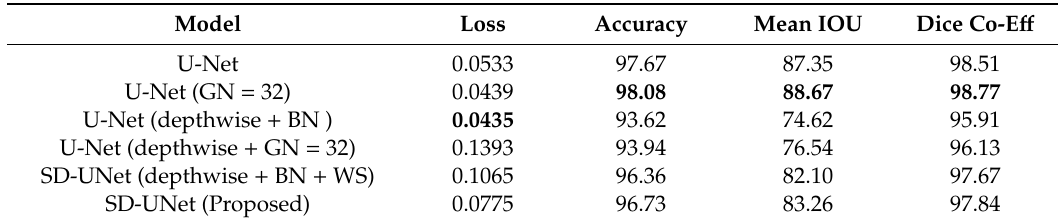
Table 2. Comparison of results on the ISBI challenge dataset.